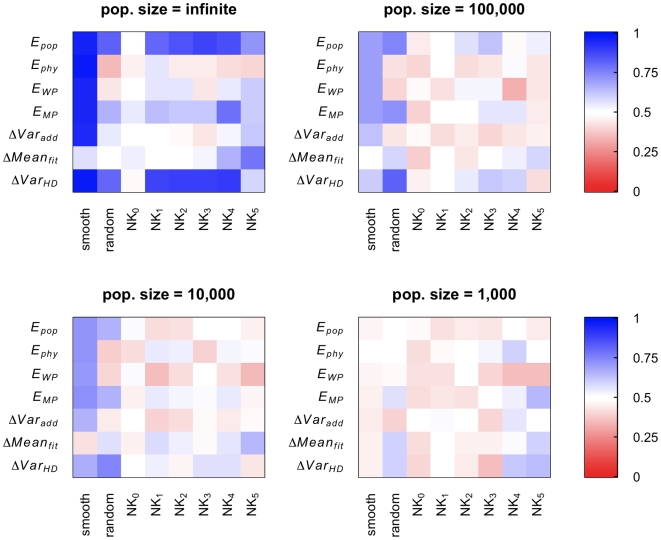
Predictor accuracy for different landscape types.Panels correspond to simulations with different population size. Predictors with absolute values smaller than 10−15 were considered numerical artifacts and were instead assigned values of −1 or 1 at random. This was done in particular for NK0 landscapes where epistasis is always 0 and thus selection for or against sex is absent in infinite populations. Such substitution is appropriate, because all predictors rely on sign and not magnitude in predicting the outcome of the competition phase.